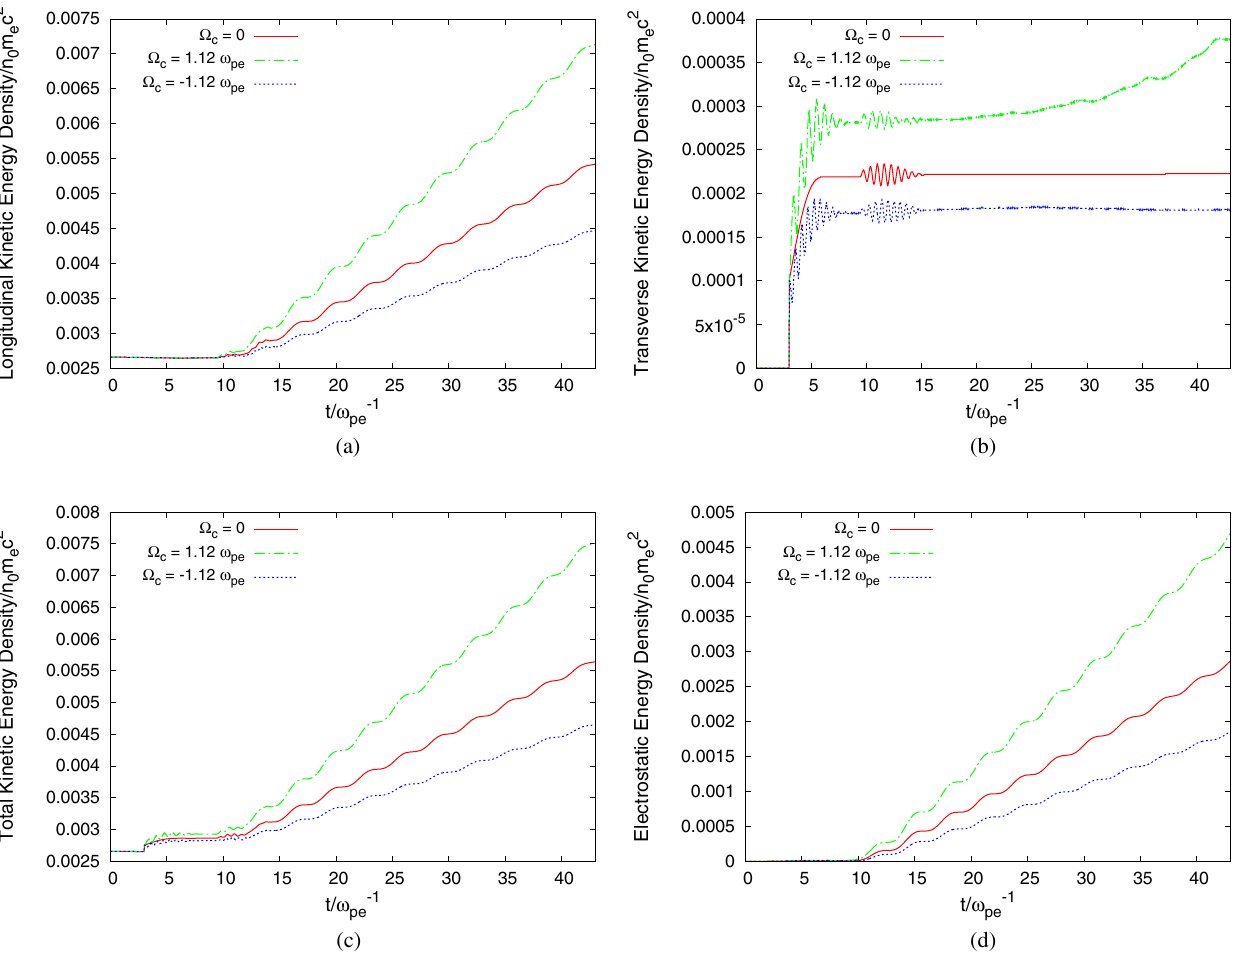
FIG. 4. Comparison of time evolution of (a) longitudinal mean kinetic energy density of electrons, (b) transverse mean kinetic energy density of electrons, (c) total kinetic energy density of electrons, and (d) electrostatic energy density of wakefields, which are generated by RCP laser pulse in a nonmagnetized plasma Ω c ¼ 0 (red solid line), plasma which are embedded in an external magnetic field in positive x direction Ω c ¼ 1 . 12 ω (green dash dot line) and negative x direction Ω c ¼ − 1 . 12 ω (blue dot pe pe